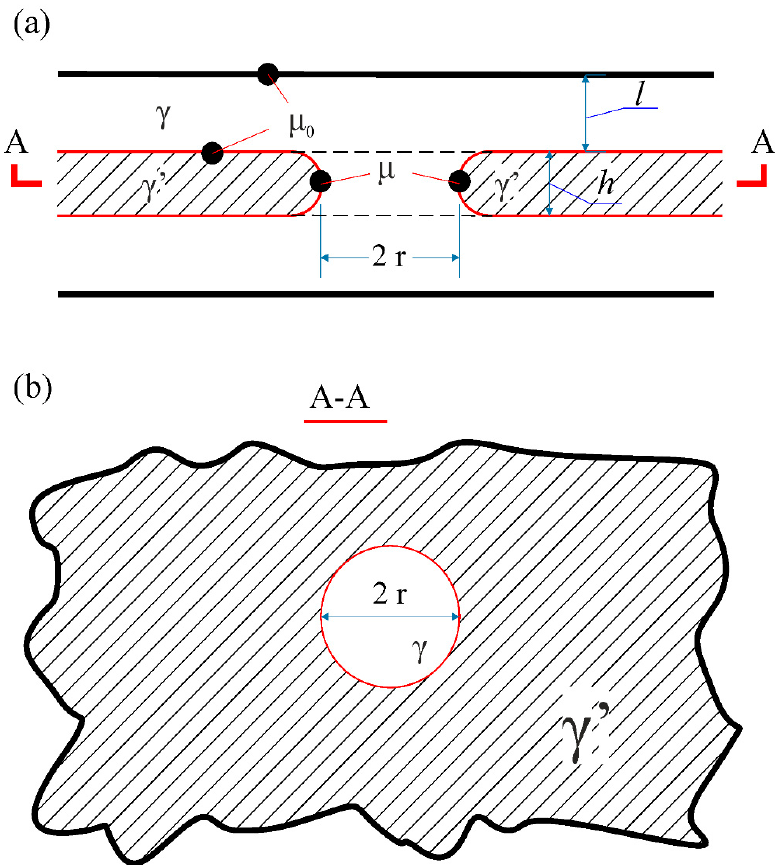
Figure 6. Schematic representation of a hole ‐ like defect in the plate of the γ ’ ‐ phase; ( a , b ) the sections perpendicular and parallel to the layers, accordingly. Open access from Razumovskii I.M. et al. [30].